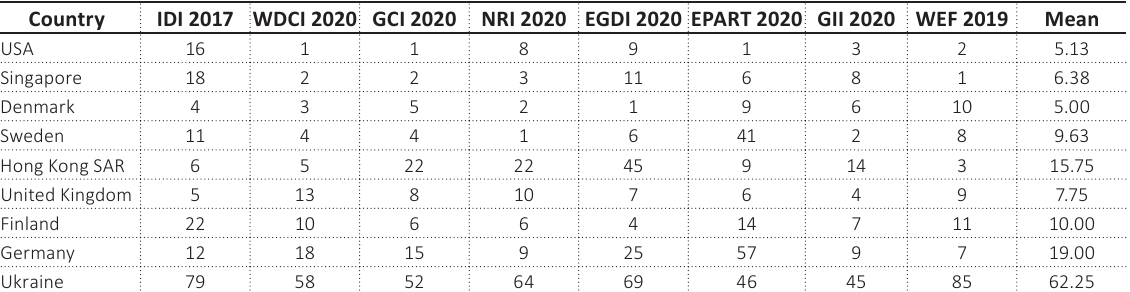
Table 1. Ratings of the digital economy of the world according to various